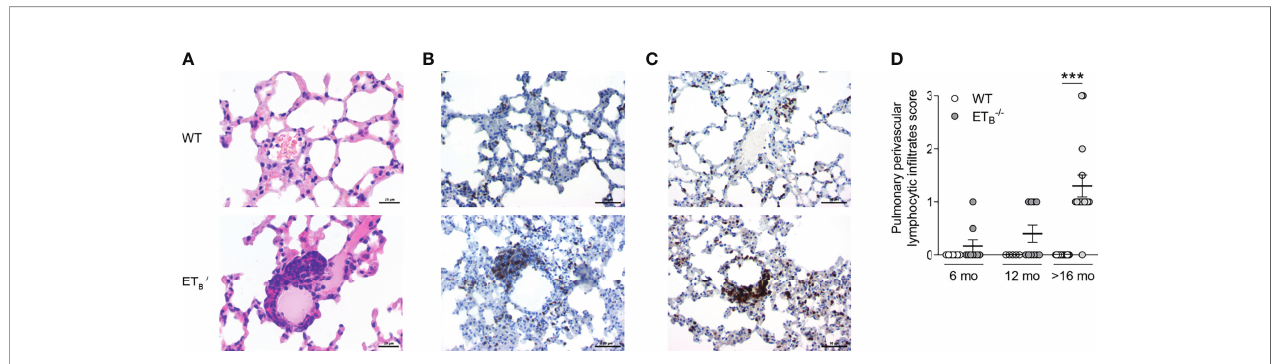
FIGURE 4 | ET B de fi ciency was associated with peripheral perivascular lymphocytic in fi ltrates in the lung. Lungs of 6-, 12-, and >16-mo-old rescued endothelin B receptor- de fi cient (ET B-/- ) and the corresponding wild-type (WT) mice were assessed histologically following hematoxylin and eosin (H&E) stain (A) or immunohistochemical stains for CD45R/B220 (B cells; B ) or CD3 (T cells; C ). The scale bars represent 20 µm (A) or 50 µm (B, C) . Representative images of ≥ 12-mo-old mice are shown; N = 20 – 25 per group (A) or N = 3 – 5 per group (B, C) . (D) H&E-stained lung sections were analyzed and scored (0, no peripheral perivascular in fi ltrates; 1, mild; 2 moderate; 3, pronounced) by an independent board-certi fi ed pathologist, blinded to the study groups. Data are expressed as single values with mean ± SEM; N = 7 – 9 (6-mo-old group), N = 5 – 10 (12-mo-old group), or N = 15 (>16-mo-old group). *** p < 0.001 (Mann – Whitney U